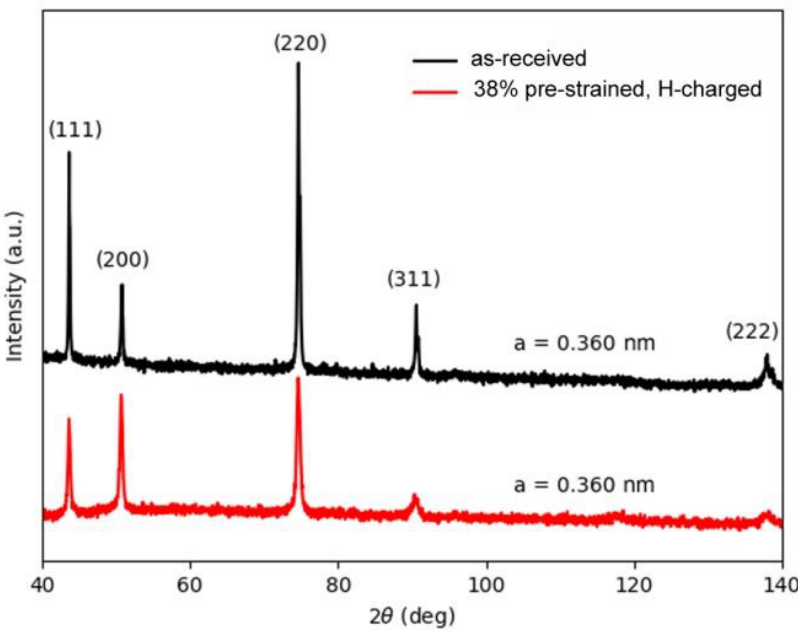
Figure 11. XRD phase analyses of as-received and 38% plastically pre-strained, hydrogen charged 316H material indicating its fully austenitic crystal structure, i.e., exclusively consisting of single FCC phase solid solution with a lattice diameter of 0.360 nm.